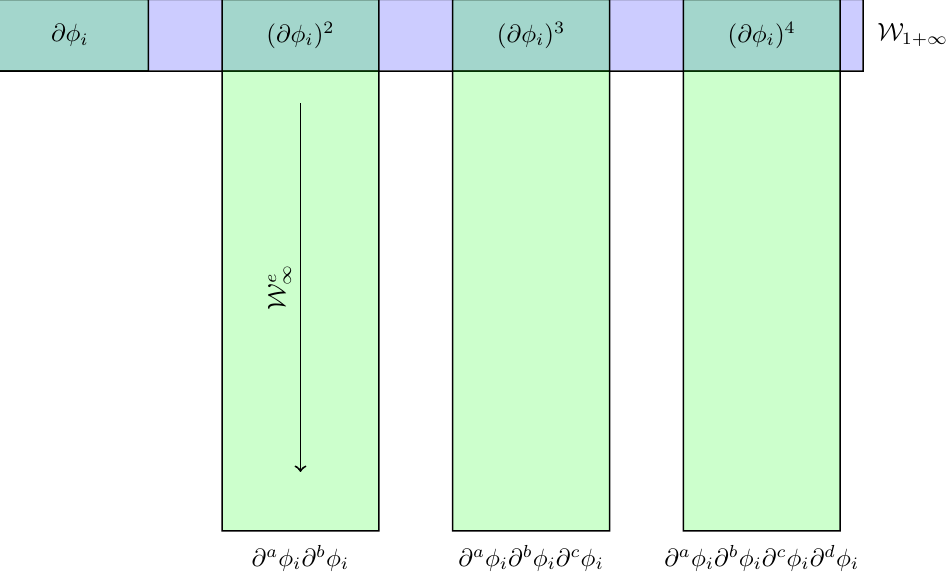
e [1] algebra while subsequent columns correspond W ∞